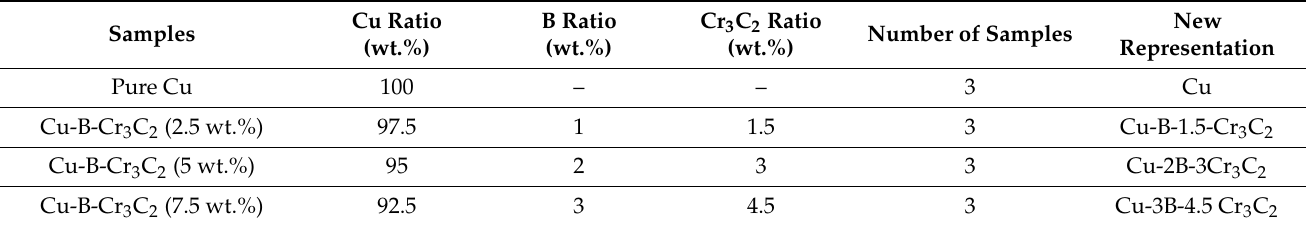
Table 1. The properties of powder